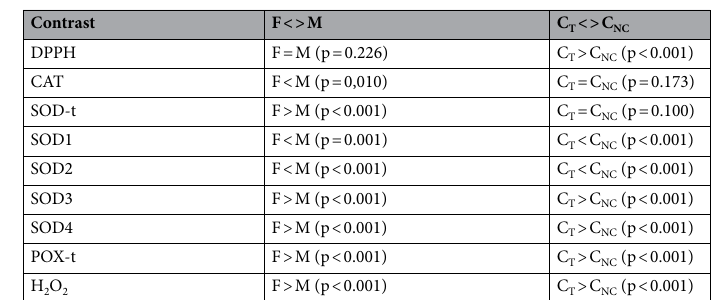
Table 2. The results of orthogonal contrast analysis in R. hastatulus plants; the values of nine parameters related to oxidative stresses were considered. F females, M males, C T cytoplasm of